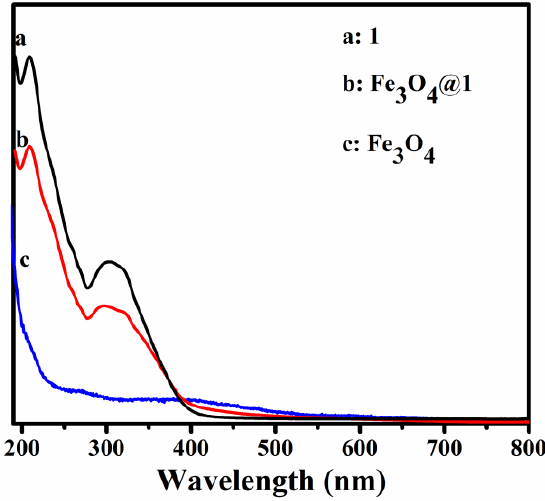
Figure 4. UV-Vis absorbance spectra of ( a ) 1 , ( b ) Fe 3 O 4 @1 and ( c ) Fe 3 O 4 dispersed in H 2 O.